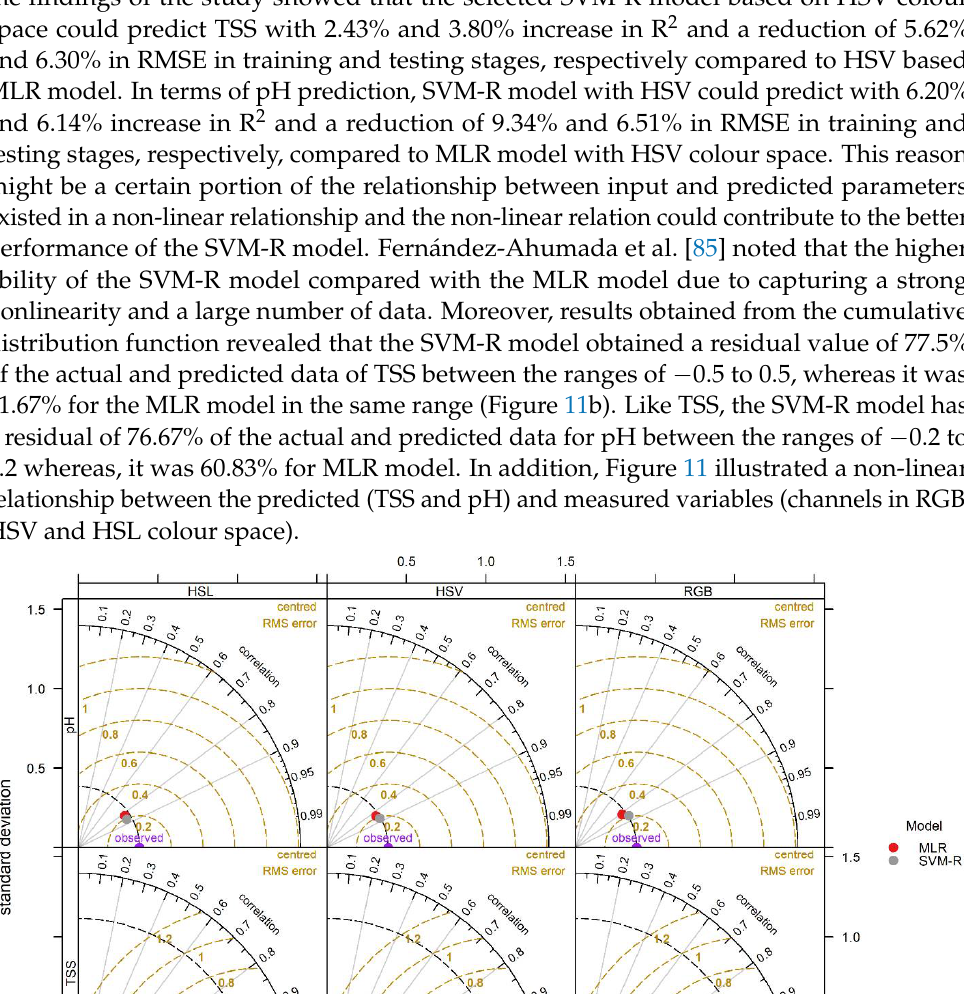
Figure 11. Cumulative distribution analysis using MLR and SVM-R models, ( a ) graph calculated from measured and predicted pH values ( b ) graph calculated from measured and predicted TSS content data during the testing period. 3.7. Sensitivity Analysis of Colour Spaces To find out the effect of each channel, i.e., Hue, Saturation and Value, of HSV colour spaces, a sensitivity test was carried out for the SVM-R and MLR models. The ability of SVM-R and MLR models little decreased when they were run without the S value during the pH prediction (Figure 12). As shown in Figure 12, without the S as an input value, SVM-R and MLR obtained the lowest R 2 (0.717 and 0.661) and the highest RMSE (0.196 and 0.223) in the testing stage, respectively. Therefore, it can be said that S was the most